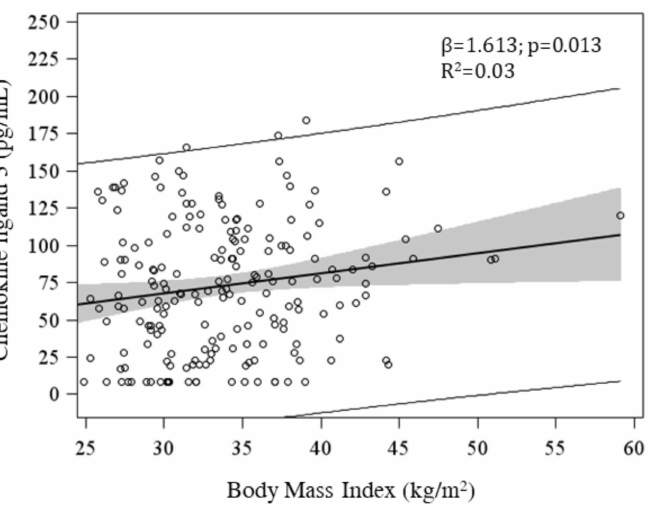
Figure 1. Association of BMI with plasma CCL3. Model was adjusted for HOMA-IR index. CCL: chemokine ligand; CI: Confidence Interval; GM_CSF: granulocyte-macrophage colony-stimulating factor; IL: interleukin; IFN- γ : Interferon gamma; q-FDR: False Discovery Rate; TNF- α : Tumor Necrosis Factor alpha; TNF- β : Tumor Necrosis Factor beta. Table 3. Association of BMI with methylation of clock genes.